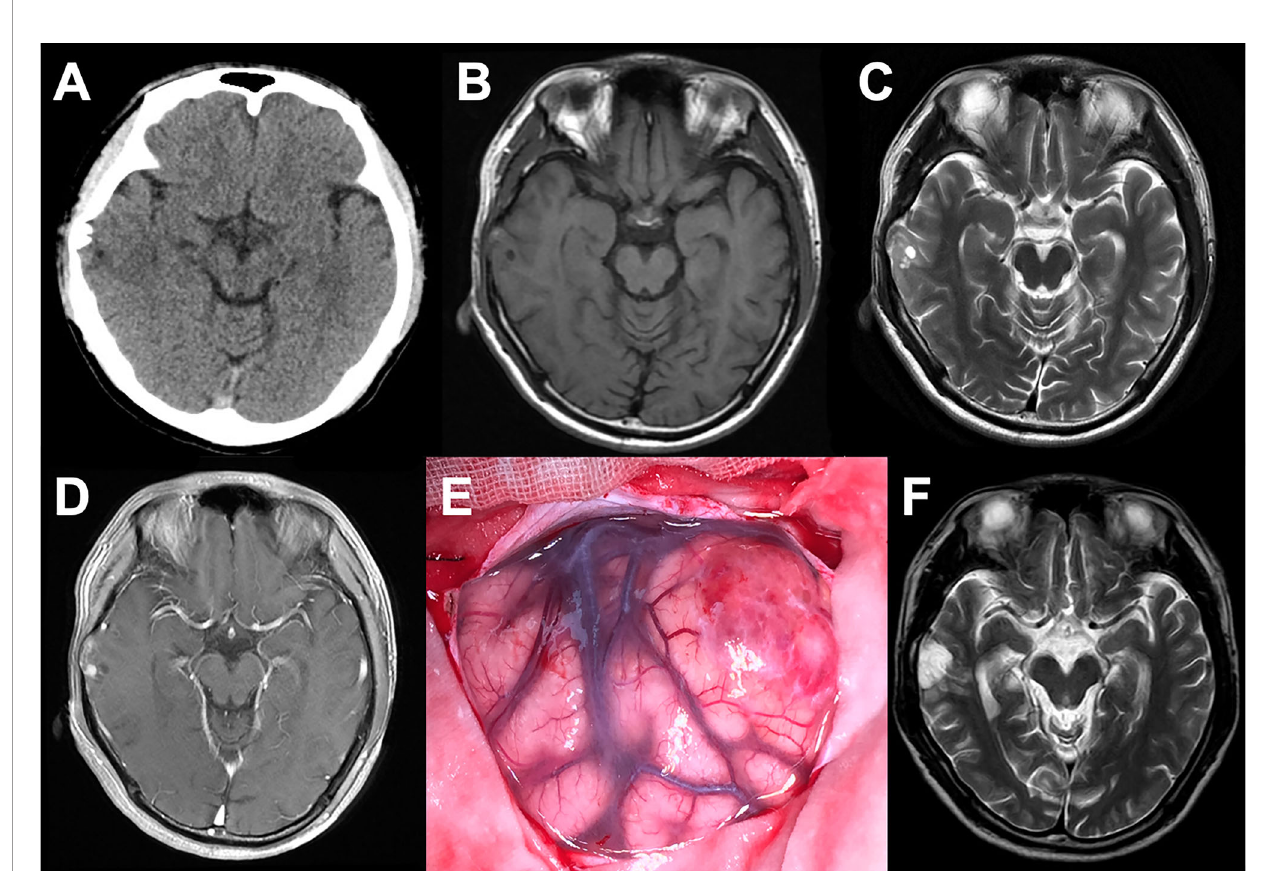
FIGURE 2 | Data of case c. (A) Axial CT showing a super fi cial situated mass in the right temporal lobe with patchy calci fi cation (B – D). Preoperative MR scans. The mass displayed a heterogeneous signal with cystic components, and a hypointense signal on T1WI, a hyperintense signal on T2WI, and partial enhancement on T1W1 post-gadolinium imaging. (E) Operative view before tumor resection. (F) Postoperative MRI showing the gross-total resection. The patient was seizure-free for 22